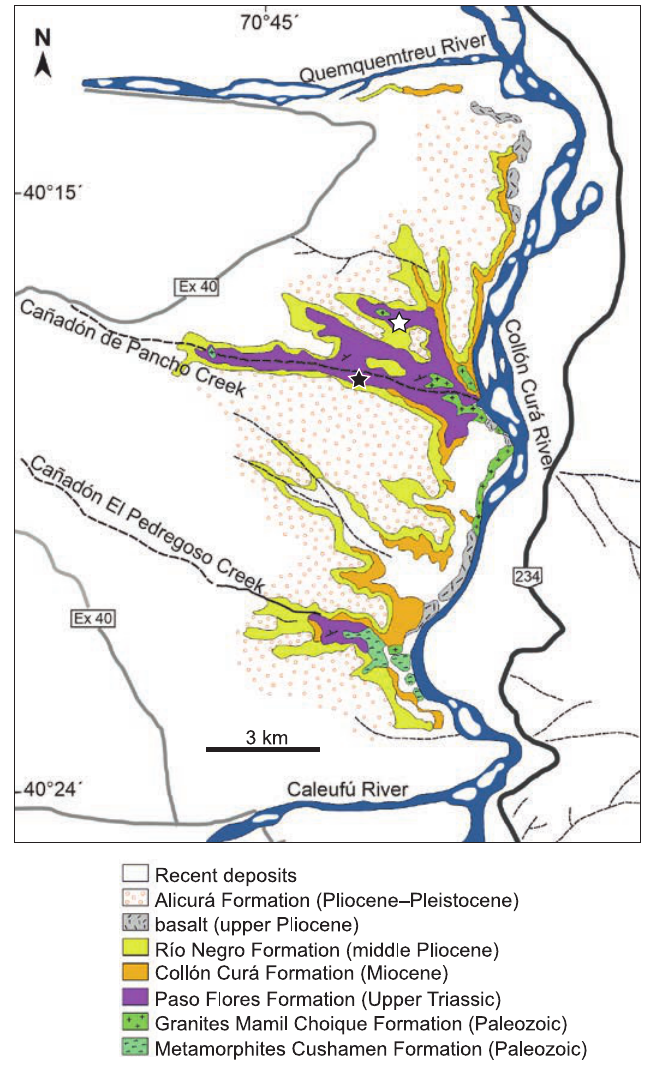
Fig. 3. Geologic map showing the outcrops of the Paso Flores Formation at Cañadón de Pancho area; white star shows the location of fossil flora recorded and studied previously (Spalletti et al. 1988; Arrondo et al. 1991; Ganuza et al. 1995; Artabe et al. 1994; Morel et al. 1999), black star shows the location of the studied plant remains described herein (adapted from González Díaz